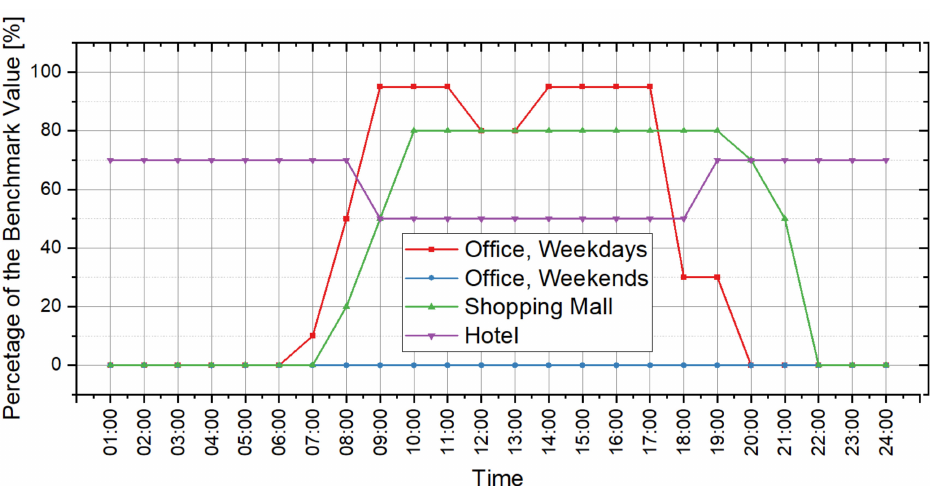
Figure 7. Schedule of occupant